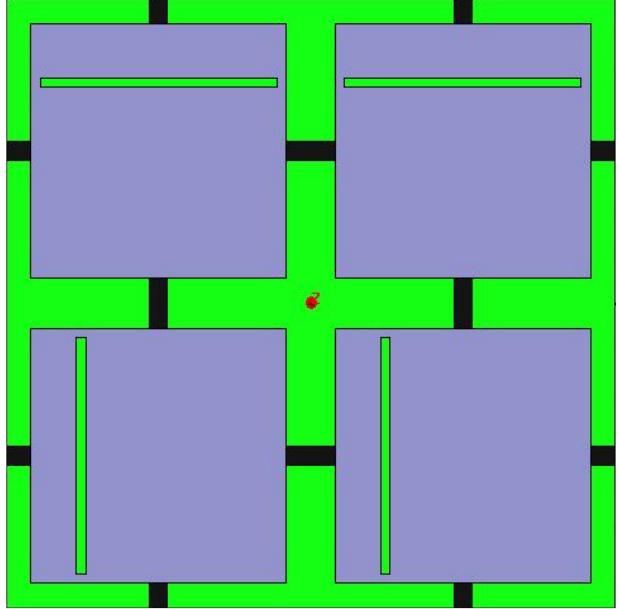
Figure 6 : A 2 X 2 unit cell geometry of the modified